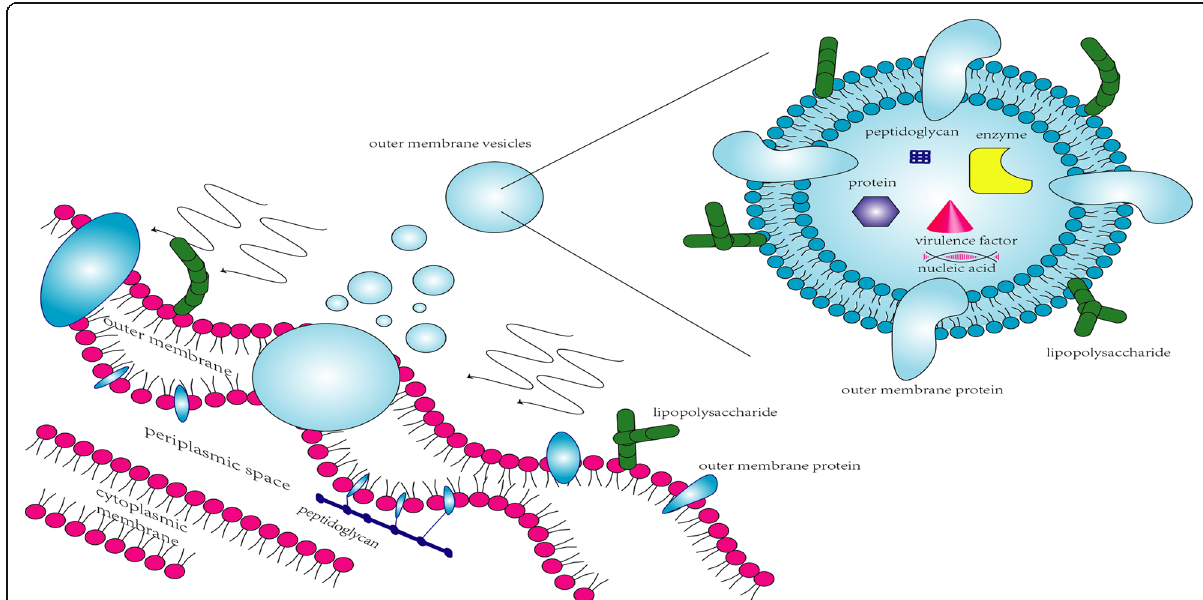
Fig. 1 Visualization of the outer membrane vesicles about structures and components. Legend section: nucleic acid; virulence factor; protein; enzyme; peptidoglycan; outer membrane protein; lipopolysaccharide; outer membrane vesicles; outer membrane; periplasmic space; cytoplasmic membrane